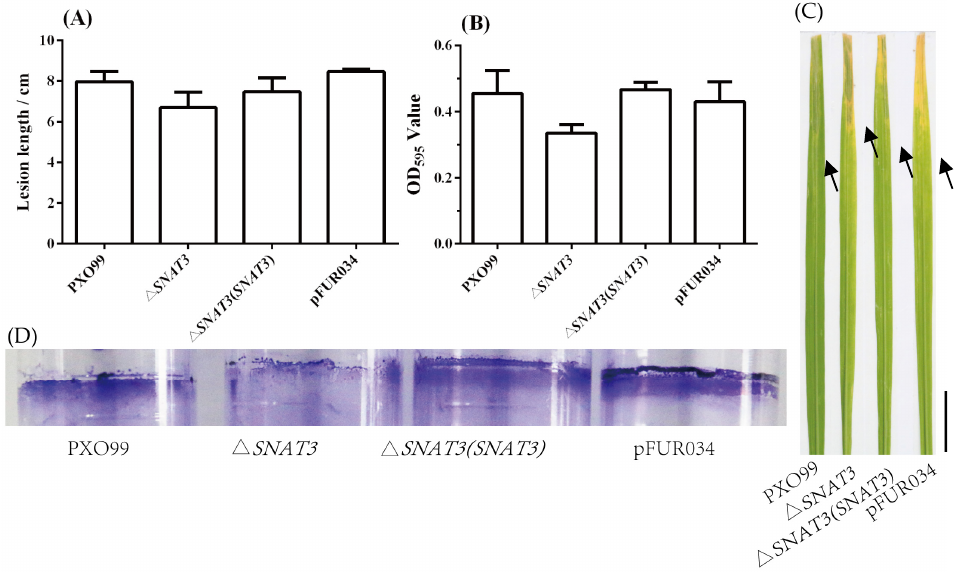
Figure 7. Characterization of the role of xoSNAT3 in Xoo pathogenicity and biofilm formation. ( A ) Lesion length of Xoo , △ xoSNAT3 mutant and complemented strain in susceptible Nipponbare rice, at 7 days post ‐ inoculation. ( B ) Biofilm formation by Xoo , △ xoSNAT3 mutant and complemented strain. ( C ) Images showing the symptoms produced by Xoo , △ xoSNAT3 mutant and complemented strains in rice leaves. ( D ) Images showing crystal violet staining of the biofilm formation by Xoo , △ xoSNAT3 mutant and complemented strain. pFUR034 refers to Xoo strain carrying mentioned blank plasmid as a mock control. Arrow refers to junction between disease and health areas. Bar = 3 cm.